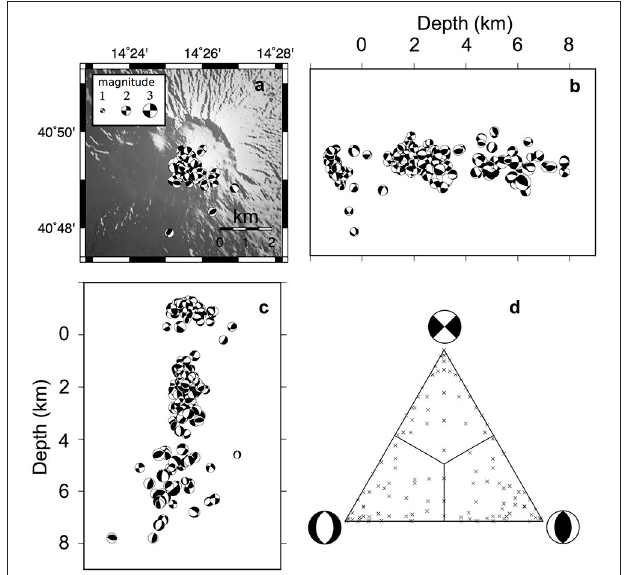
FIGURE 5 | Mt. Somma-Vesuvius. Focal mechanisms dataset plotted on a shaded map (A) , on a N-S (B) , and an E-W (C) cross sections. (D) The distribution of focal mechanisms on a triangular Frohlich diagram (Frohlich, 1992). The dataset consists of 197 FPSs of earthquakes recorded from 1999 to 2012 with 0 < M < 3.6.